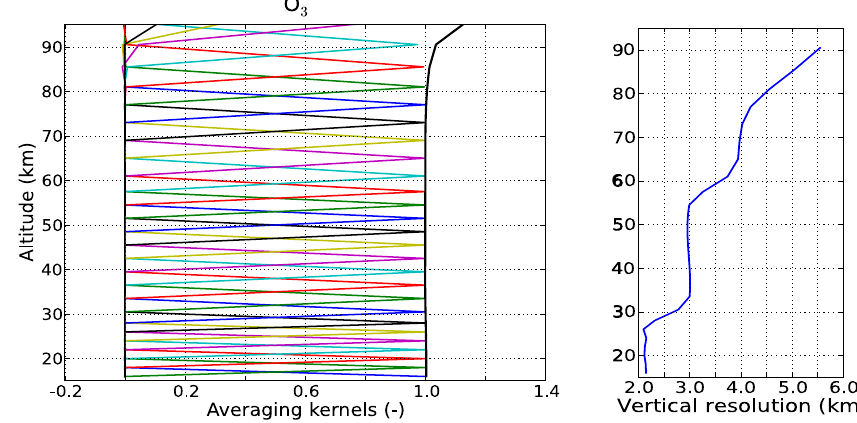
Fig. 8. Results for the O 3 profile retrieved from window A/B-w1. Left panel: same as Fig. 6. Right panel: vertical resolution.